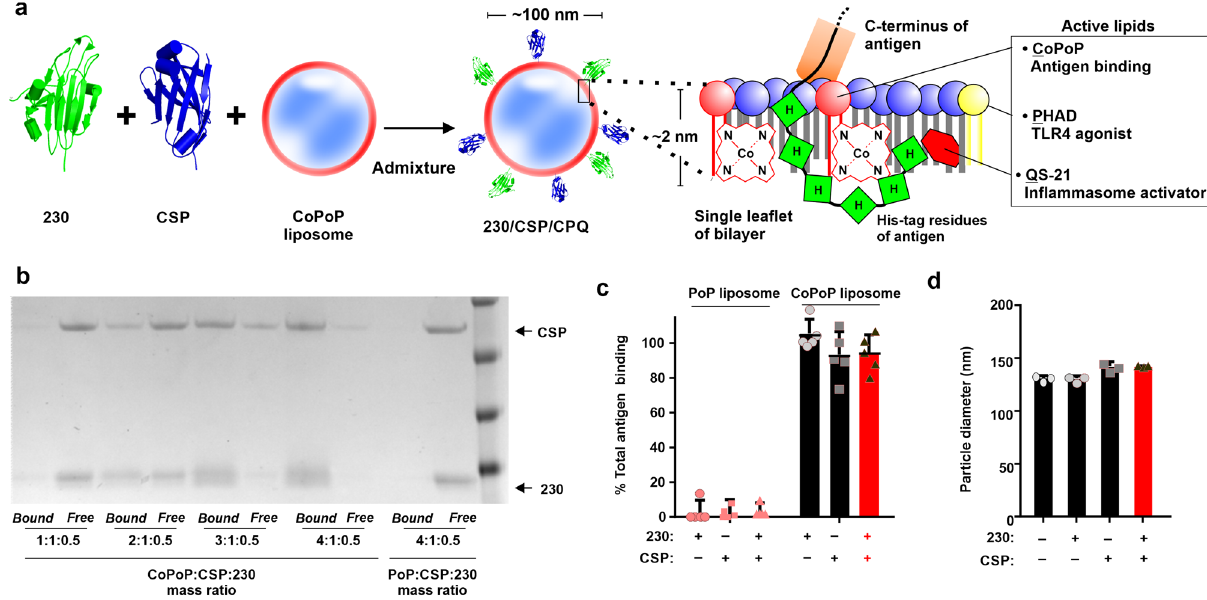
Fig. 1 Bivalent particle formation upon admixture of CSP and Pfs230D1 + with CoPoP liposomes. a Schematic representation of the bivalent CoPoP liposomes displaying Pfs230D1 + ( “ 230 ” ) and full-length P. falciparum CSP ( “ CSP ” ). b Antigen binding to CP liposomes was measured by Ni-NTA bead competition assay. Identical PoP liposomes lacking cobalt served as a control. c Binding percentage of antigens to CoPoP or PoP liposomes using a mass ratio of [CoPoP or PoP: CSP: 230] = 4:1:0.5. d Particle size before and after antigen binding. Bars show mean ± s.d for n = 3-5 replicates. Red bars indicate bivalent, liposome-displayed CSP/230.